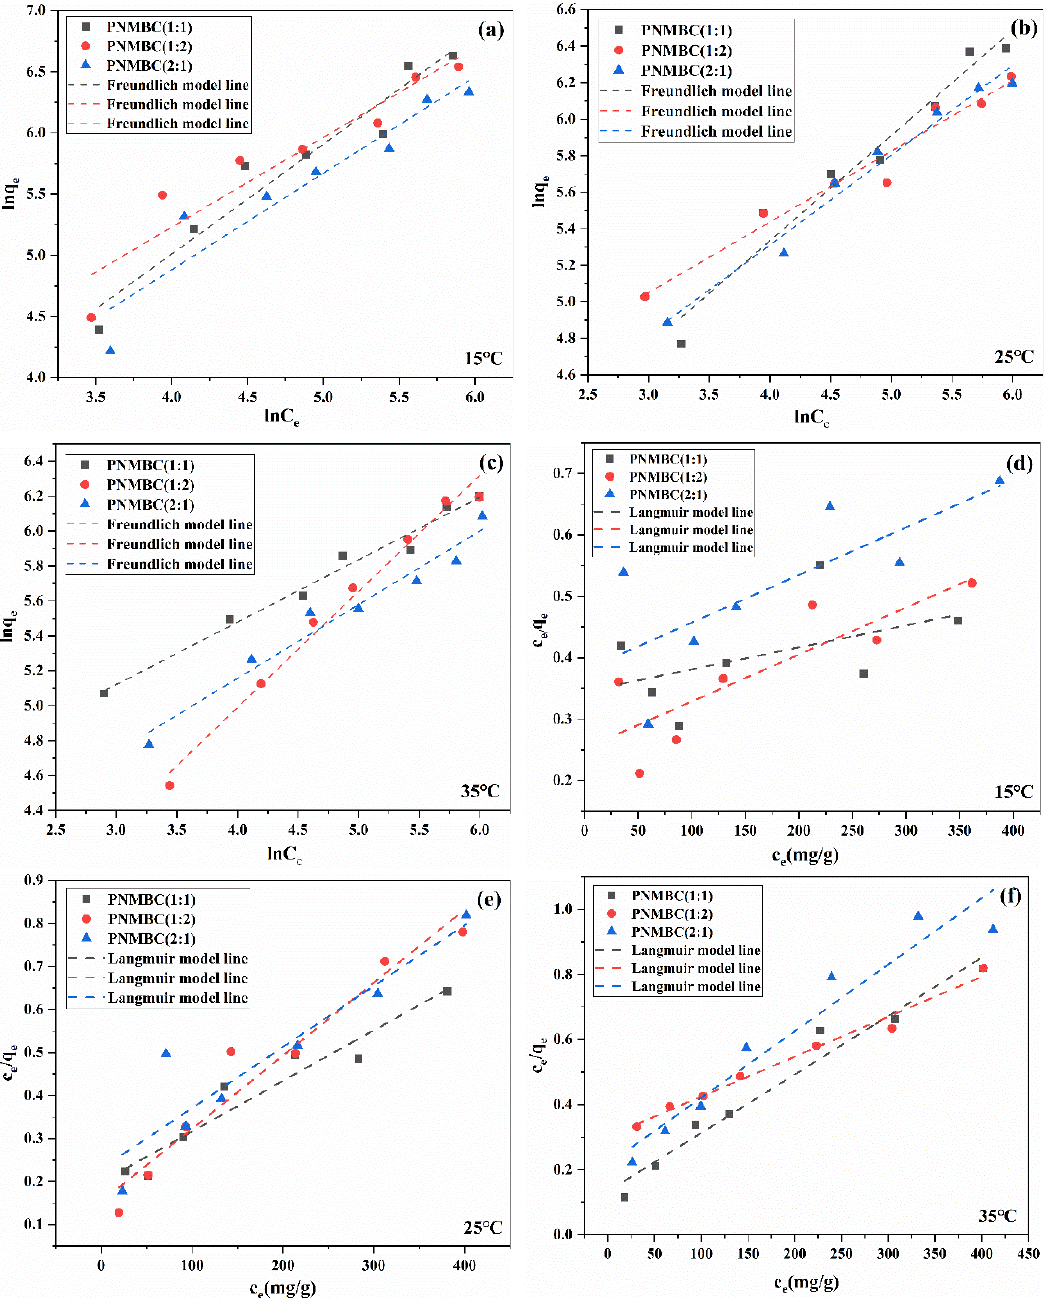
Figure 10. Isotherm fitted curves of PNMBC composites (TOCN–PEI:MB = 1:1, 1:2, and 2:1 for Cu(II)) adsorption: ( a – c ) Freundlich fits and ( d – f ) Langmuir fits. Table 2. Adsorption isotherm constants for Cu( Ⅱ ) adsorption by PNMBC at different temperatures.